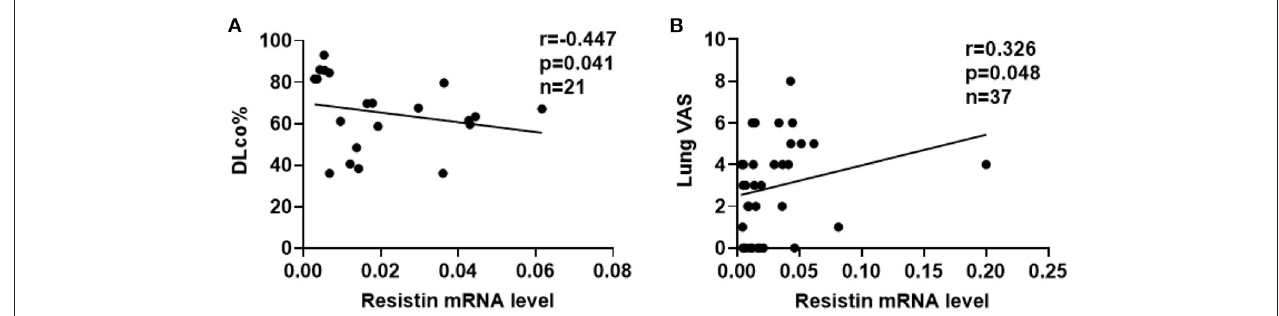
FIGURE 3 | Elevated resistin mRNA levels in PBMCs correlated with the severity of lung involvement in DM-ILD. (A) Resistin mRNA levels were negatively associated with the DLco% in patients with DM-ILD. (B) Correlation between resistin mRNA levels and lung VAS values in DM-ILD. DLco, carbon monoxide diffusion capacity; DM-ILD, dermatomyositis-related interstitial lung disease; VAS, visual analog scale.